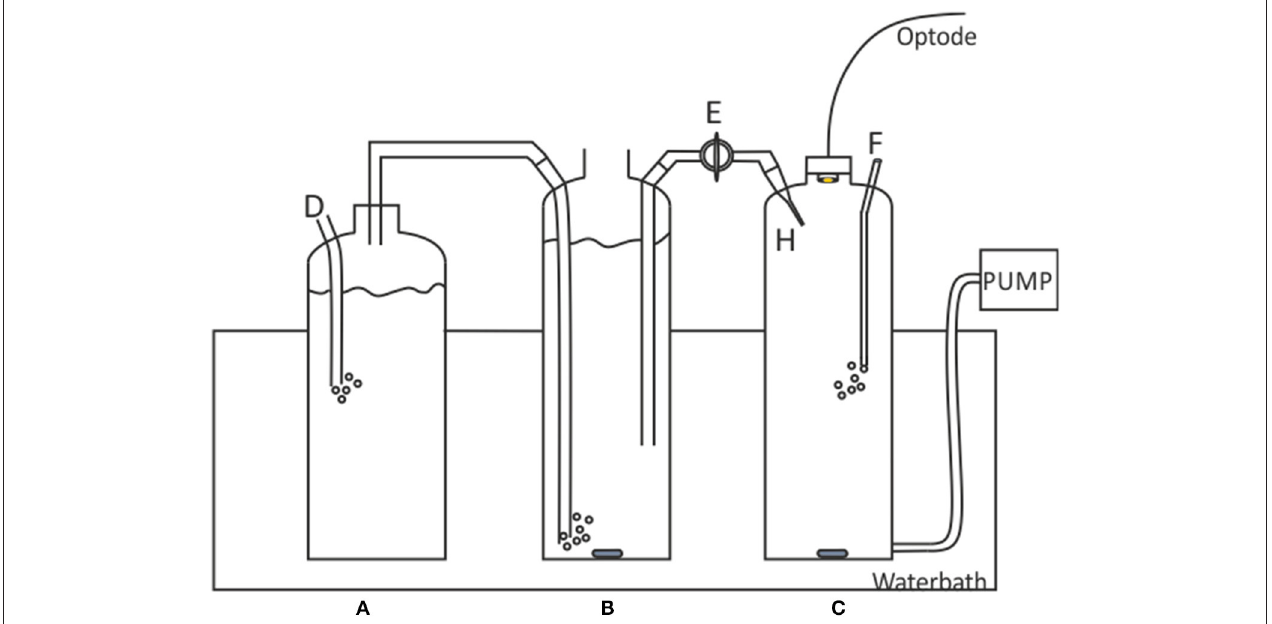
FIGURE 2 | Schematic of the Sosna calibration rig. A, 1.5L Gas humidifier; B, 2L saturated solution; C, 2L sample solution; D, CO 2 gas tube to CO 2 /N 2 gas cylinder; E, Bridge with valve; F, nitrogen gas inlet; H, Saturated solution inlet capillary. Figure adapted from Sosna et al.